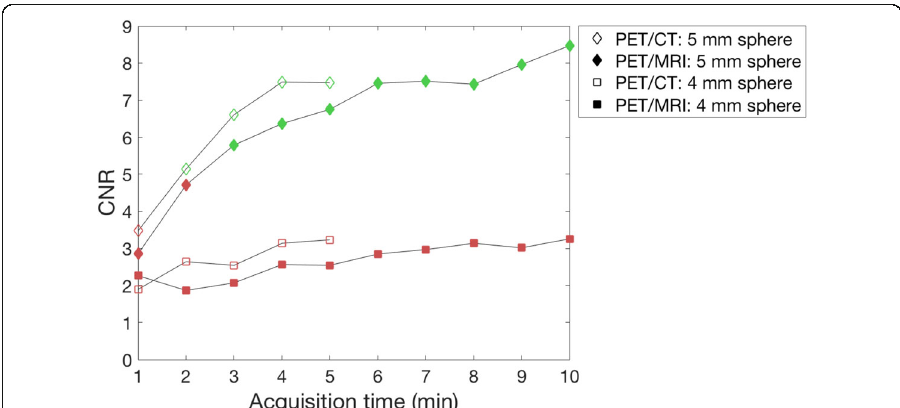
Fig. 5 Contrast-to-noise ratio (CNR) for increasing acquisition times on the PET/MRI (1 – 10 min, OSEM with PSF, 3 iterations, and 2 mm voxel size) and the PET/CT (1 – 5 min, OSEM with PSF and TOF, 3 iterations, 2 mm voxel size) for the 4-mm and 5-mm spheres in the 8:1 activity concentration. Spheres detected in the human observer study are presented in green, while non-detected spheres are presented in